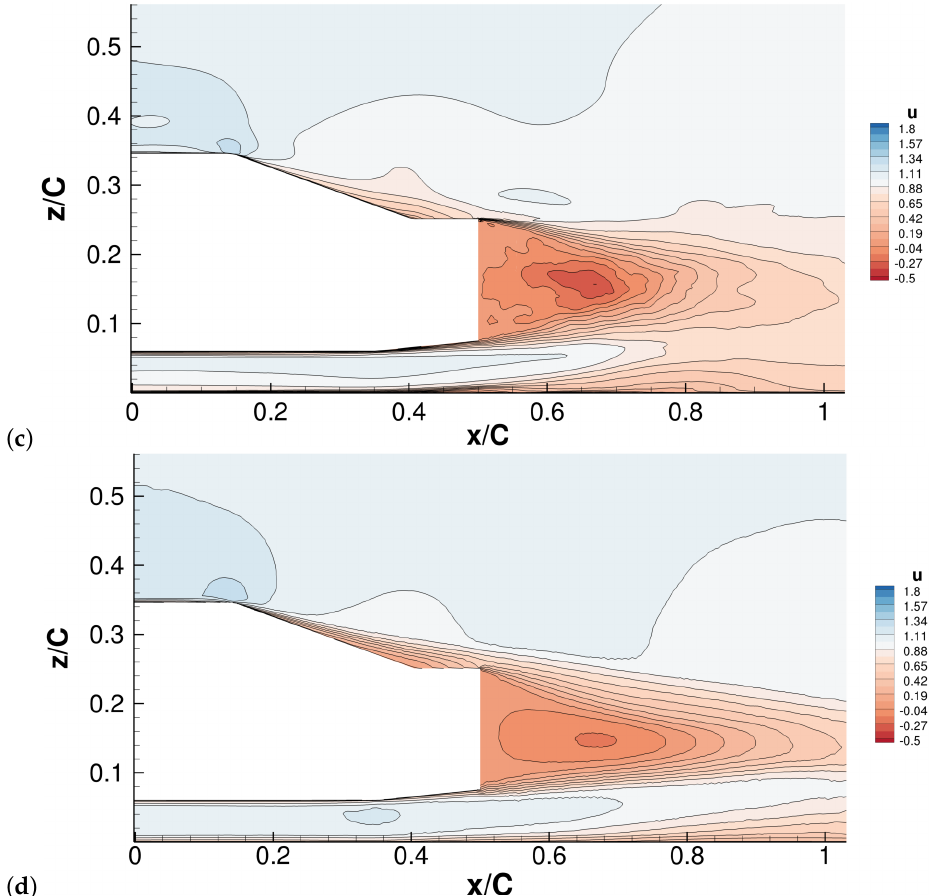
Figure 7. Comparative contours of u velocity over the centrelines of HFP3, HCP5, RANS and the U inf re-scaled experiments from [7]: ( a ) experiment, ( b ) HFP3, ( c ) HCP5 and ( d )